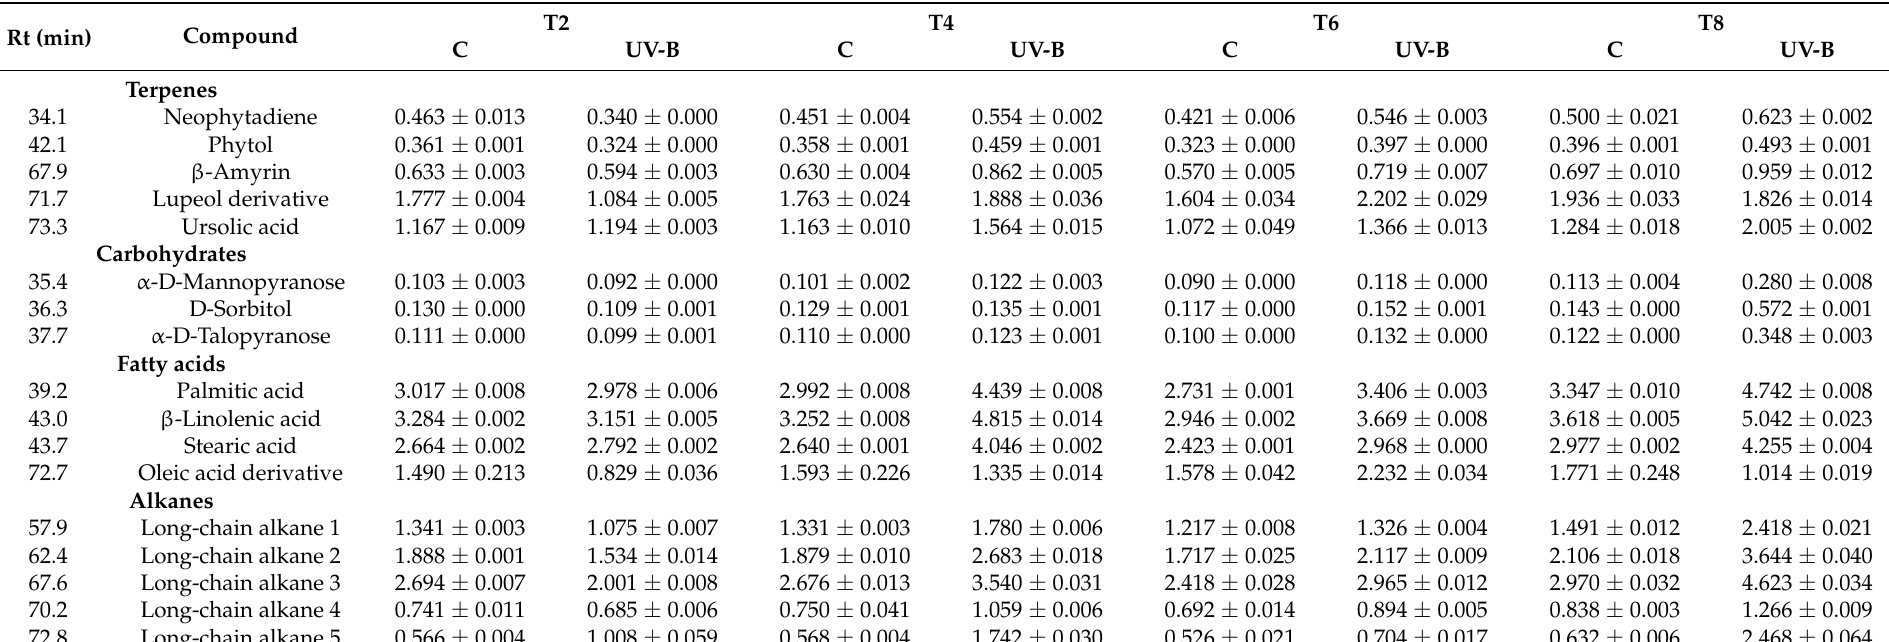
Table 3. Lipophilic profile (g kg − 1 DW) of Olea europaea leaves (Giarraffa variety) under control (C) and UV-B conditions sampled at the 2nd (T2), 4th (T4), 6th (T6), and 8th (T8) week after the onset of stress. Values are mean ± standard deviation ( n = 3). Rt—Retention time. ANOVA showed that most of chemical components were significantly affected by the main factors and their